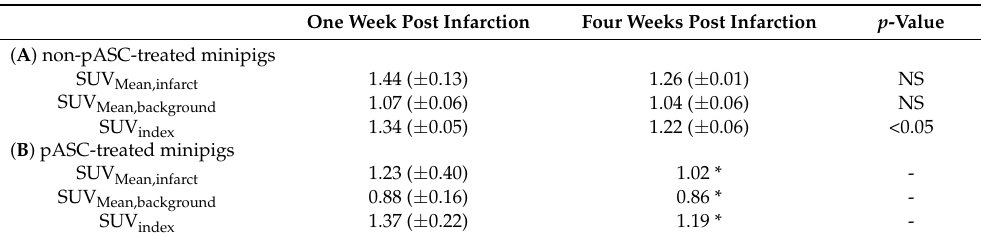
Table 2. ( A ) RGD uptake in non-pASC-treated minipigs with myocardial infarction. ( B ) RGD uptake in pASC-treated minipigs with myocardial infarction. One Week Post Four Weeks Post Infarction Infarction